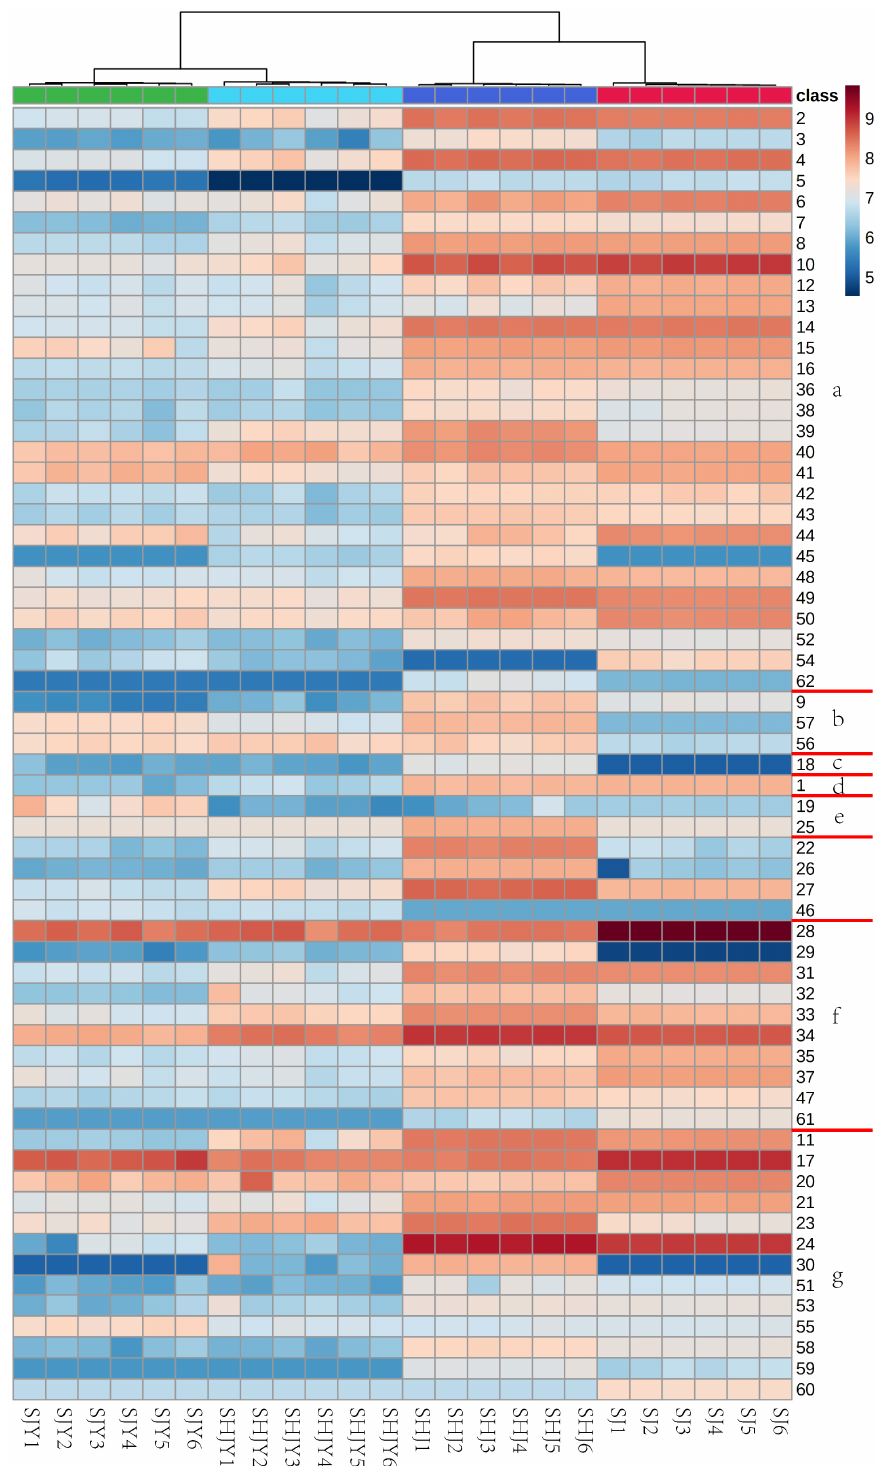
Figure 3. Heatmap of cluster analysis of content detected by HS-SPME-GC-MS. The a, b, c, d, e, f and g correspond to alkene, other, phenol, acid, aldehyde, ketone, ester and alcohol, respectively (the codes of the compounds correspond to those in Supplementary Table S3).